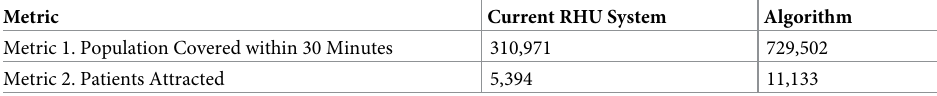
Table 4. Results of algorithm validation.